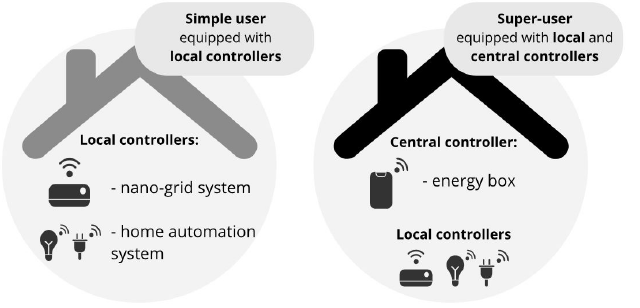
Figure 1. Equipment of simple users and super-users.